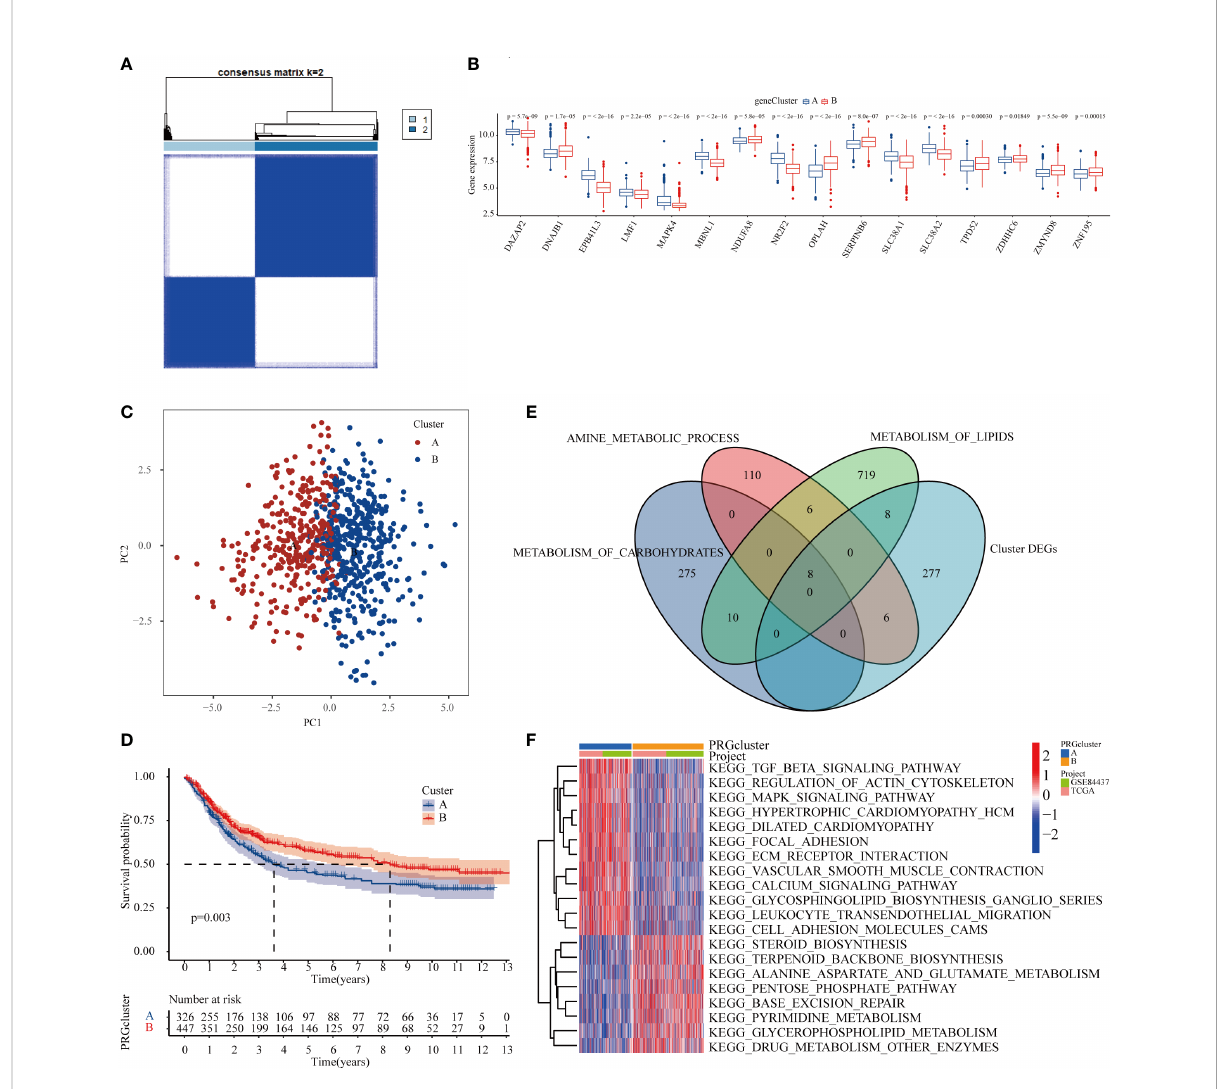
FIGURE 5 METTL3 participated in the metabolic process and affected the prognosis of GC patients by regulating the level of m6A modi fi cation and protein expression. (A) Consensus clustering of GC patients according to MTTL3-regulated m6A modi fi cation and protein expression based on TCGA and GEO datasets. (B) Histogram demostrating that the 16 genes were signi fi cantly differentially expressed between the two subtypes. (C) The PCA plot displayed that there was a signi fi cant difference between the two clusters of samples. (D) Kaplan-Meier survival curve showed that the OS of cluster B GC patients was signi fi cantly better than that of cluster (A) . (E) Intersection genes between the DEGs and three major energy metabolism pathways in patients with subtypes A and (B) . (F) Heatmap of GSEA enrichment analysis of DEGs in patients with subtypes A and